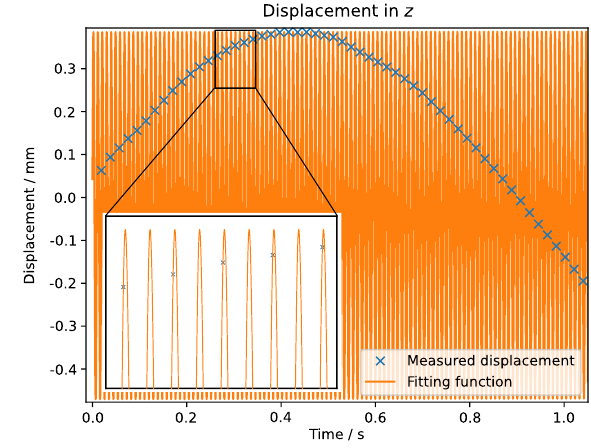
Figure 8. Displacement in z from DIC and the fitted sine function.